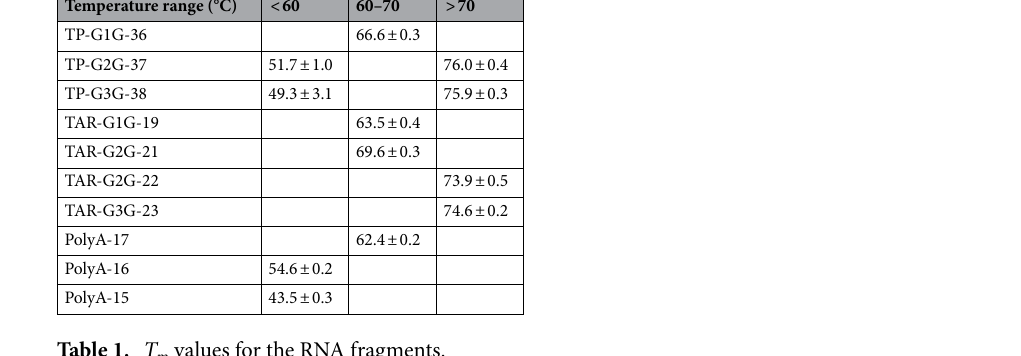
Table 1. T m values for the RNA